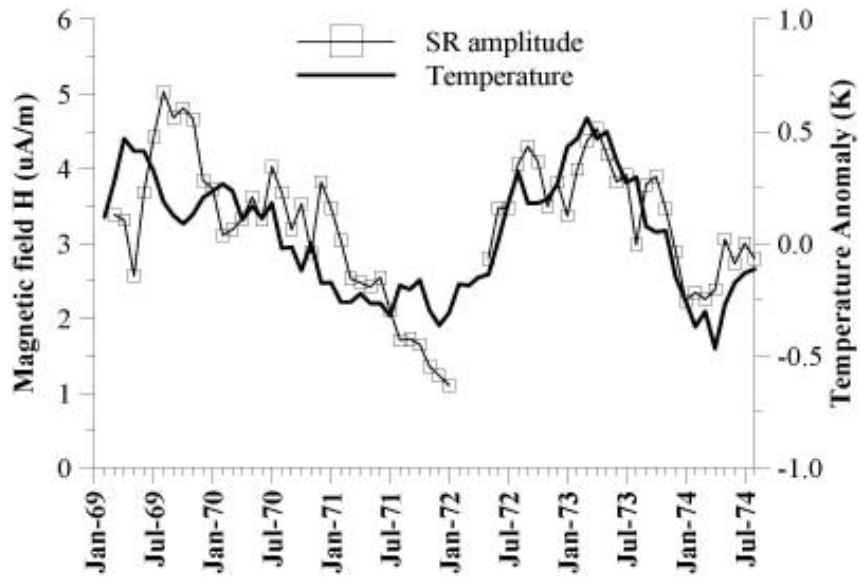
Fig. 1. Correlation between the global temperature and the intensity of Schumann resonance oscillations (adopted from Williams, 1992).